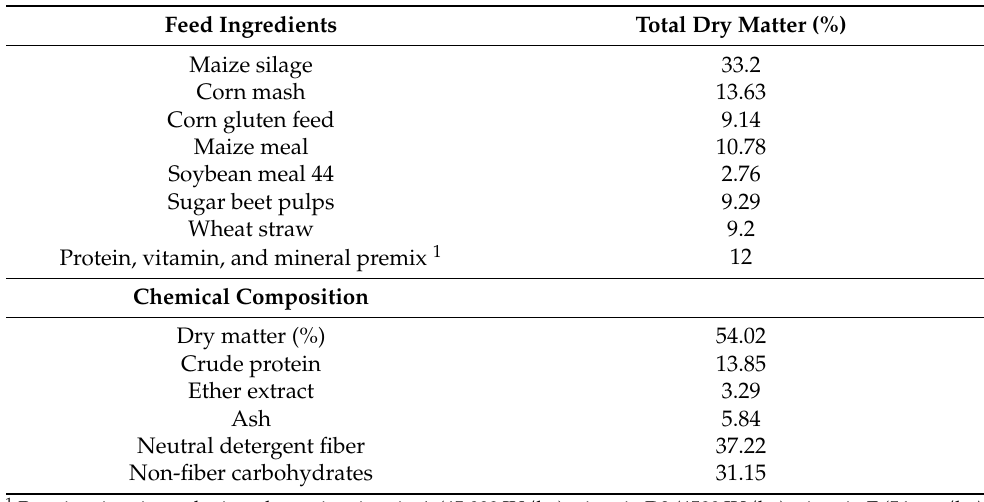
Table 1. Ingredients and chemical composition of the total mixed ratio used for the heifers in the